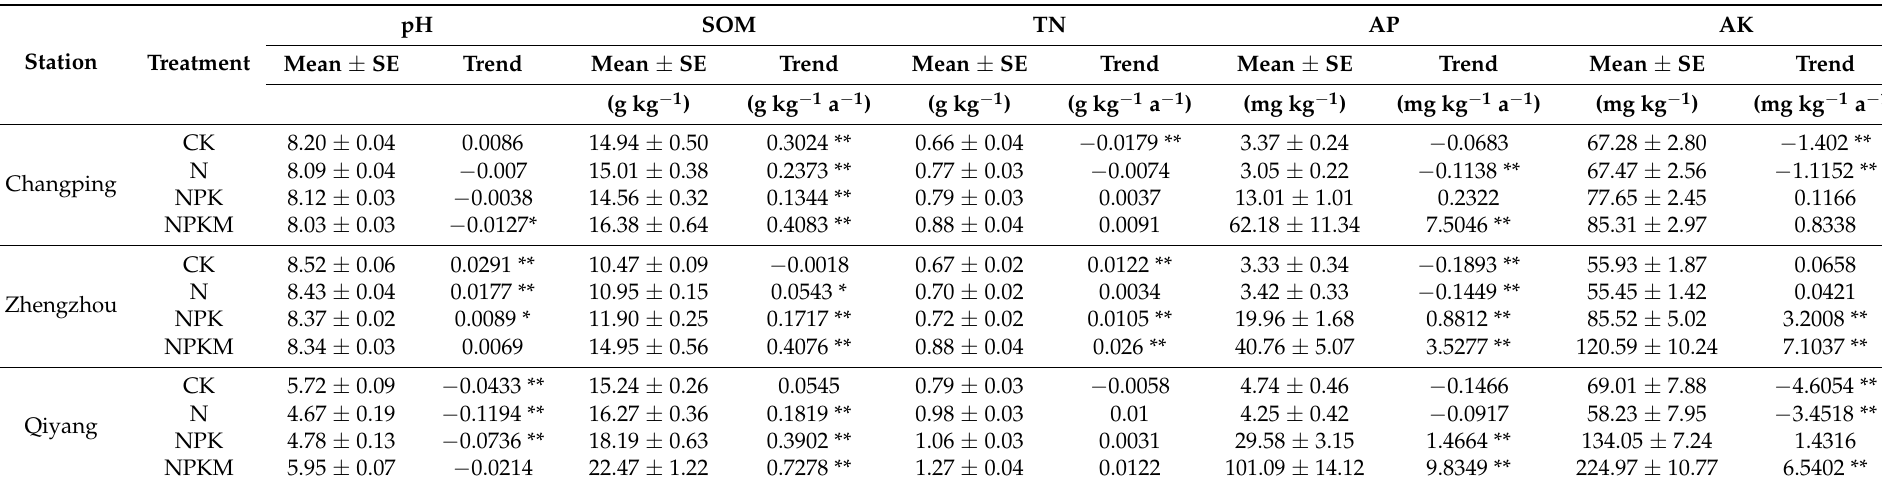
Table 1. The changes of soil fertility factors under different fertilization regimes in the three experimental sites during 1991–2010.